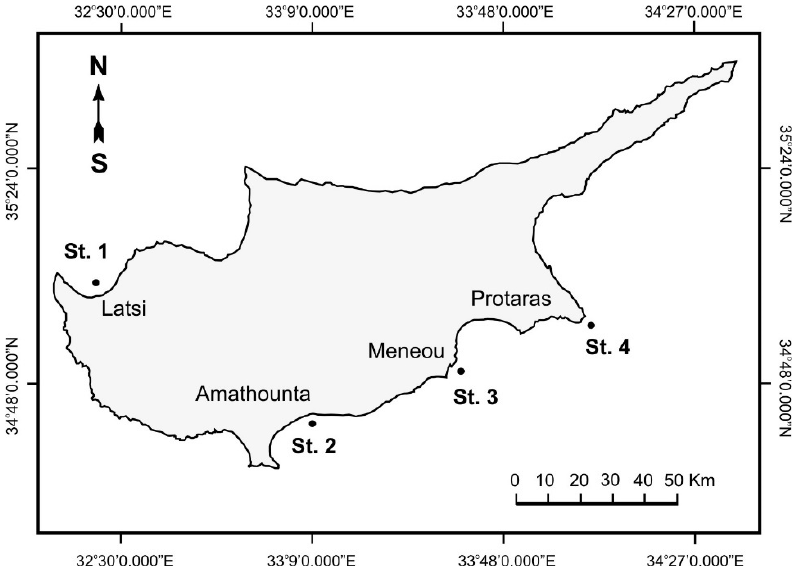
Figure 1. The map of Cyprus with the four sampling stations (St.1–St.4) situated in the areas of Latsi, Amathounta, Meneou and Protaras, respectively.